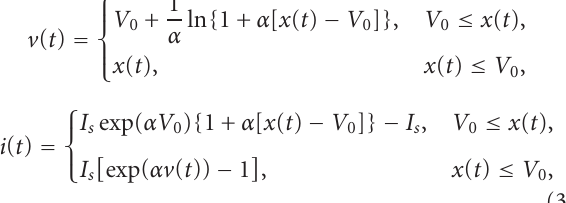
circumvent this, the state variable in (2) is changed from voltage to a fictitious nonconventional variable, x ( t ). This state variable is identical to the junction voltage below some nonzero threshold value, say V 0 , and is defined as a linear function of the current in (2) above V 0 . Care is taken to ensure that the current and its derivatives are continuous at x = V 0 . The equations for diode voltage and current are now expressed as